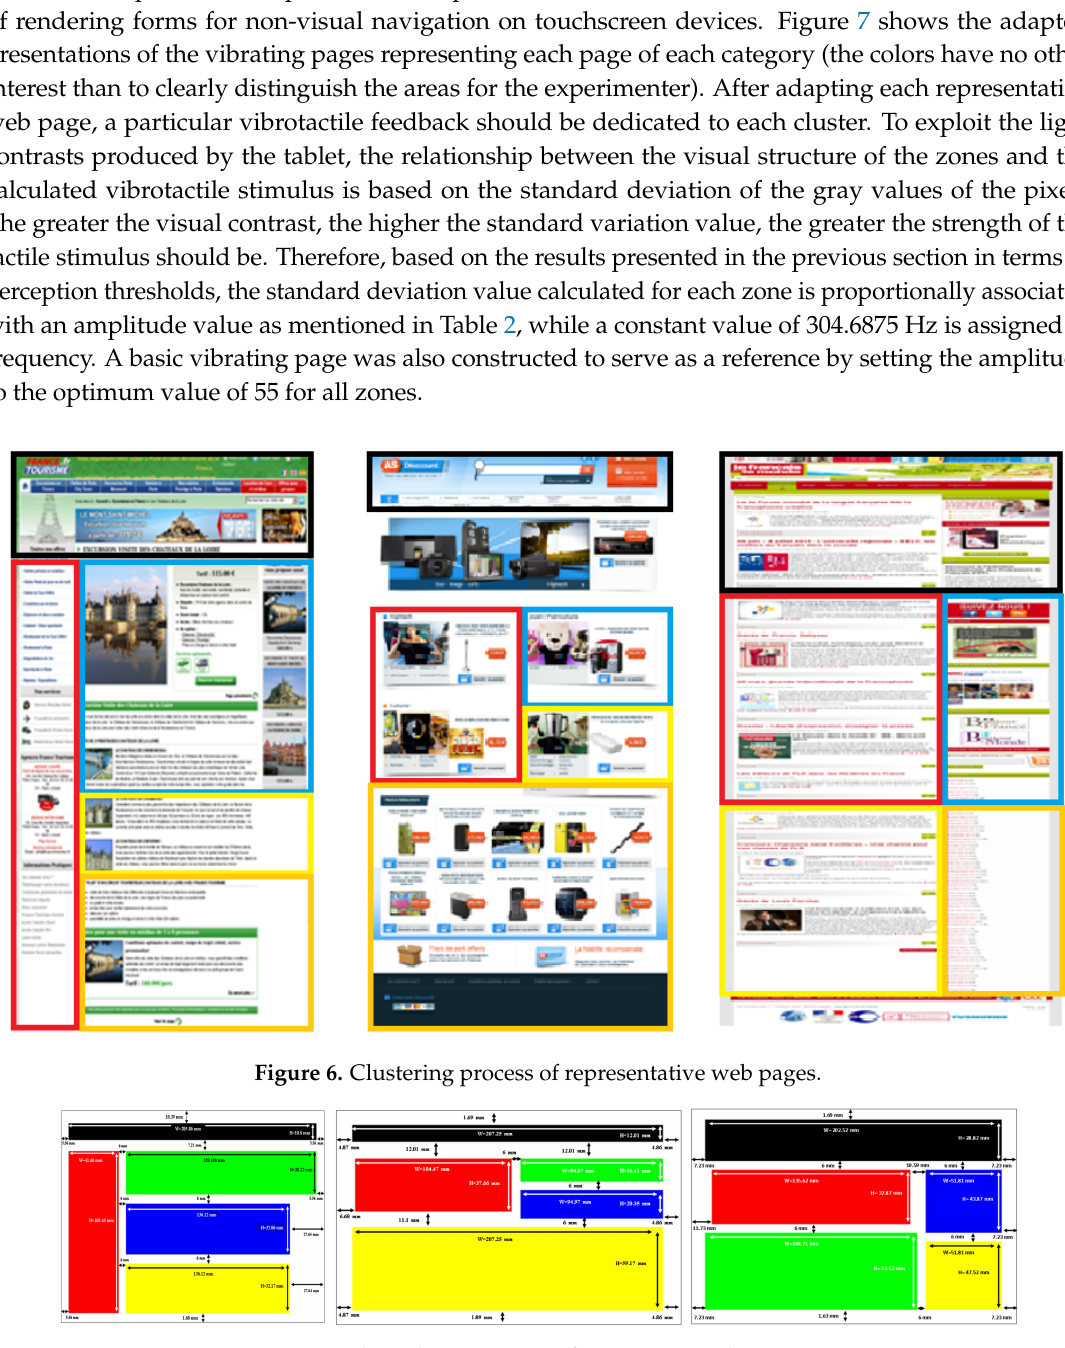
Figure 7. Adapted segmentation for experimental purposes. Table 2. Amplitude values for the vibrotactile